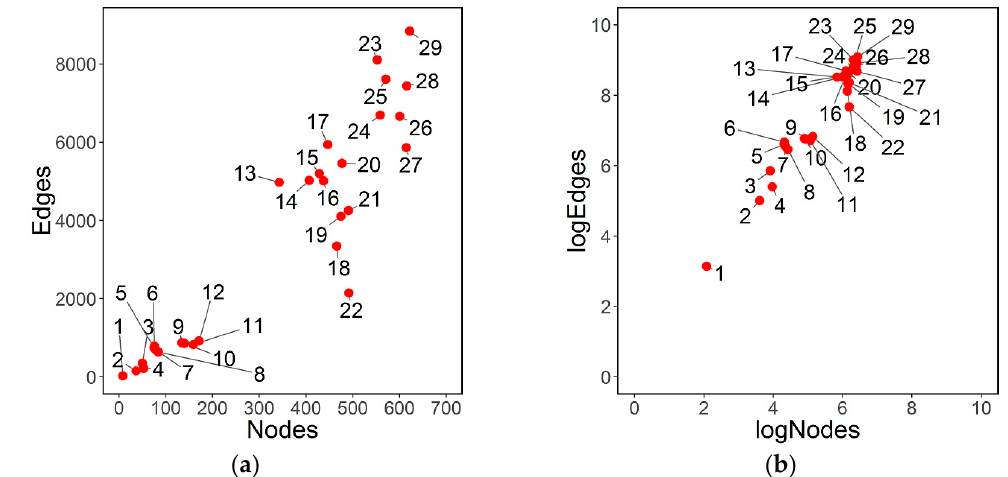
Figure 1. ( a ) Relationship between edges and nodes, ( b ) Relationship between edges and nodes in logarithmic scale.